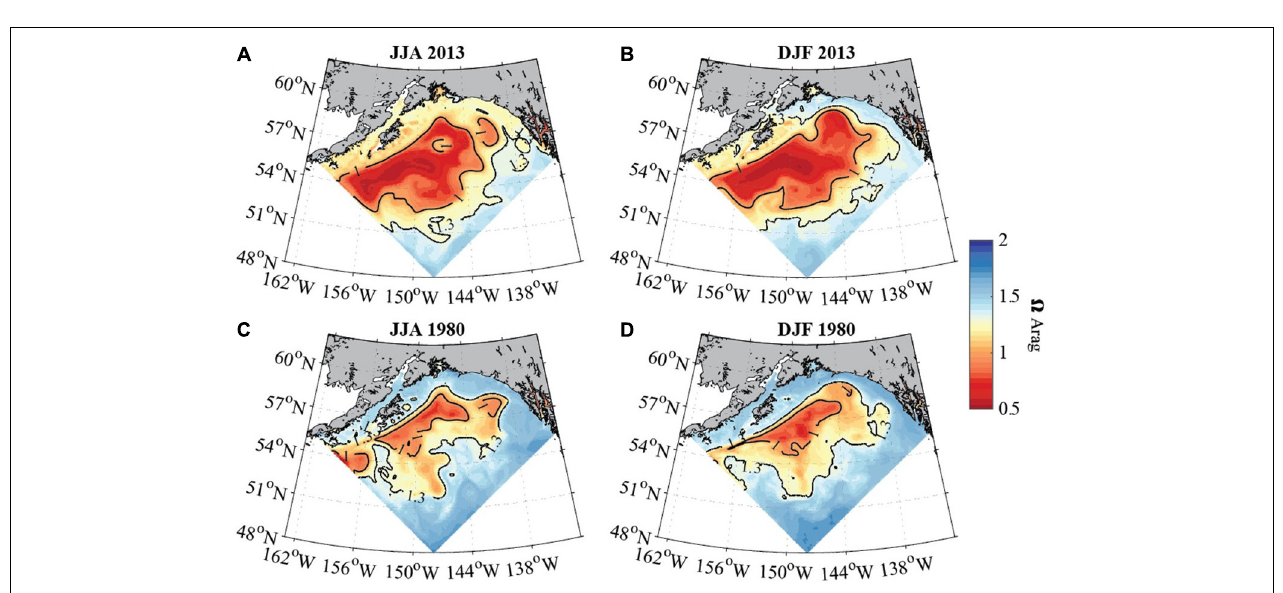
FIGURE 5 | Average seasonal aragonite saturation state (modeled data) across the upper 50 to 100 m in the GoA for June to August ( A,C ; left column) and December to February ( B,D ; right column) for 2013 (top row) and 1980 (bottom row). Solid black contour lines depict aragonite saturation state equal to 1 and 1.3. White areas show locations where the topography is shallower than 50 m. Model output is from the GOA-COBALT hindcast simulation described by Hauri et al. (2020).